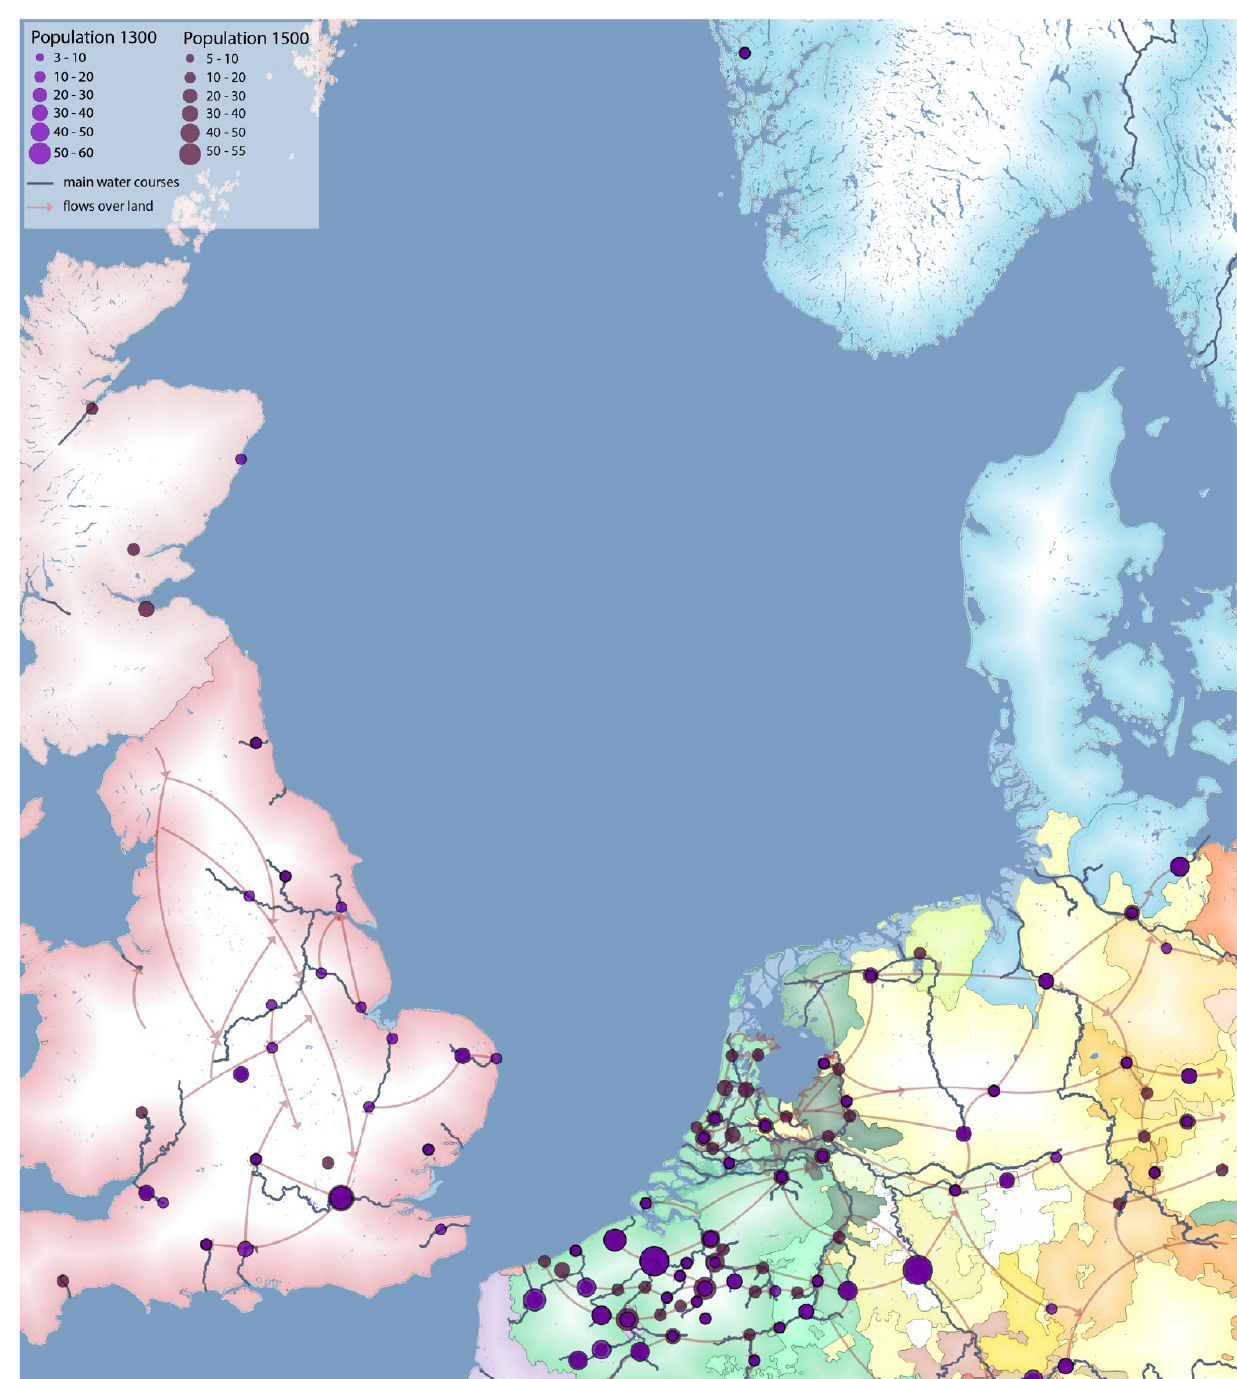
Figure 4. Cities around the North Sea area with the largest populations in 1300 and 1500, combined with political bound‐ aries and flows of goods and people over land and water in 1500. Map by Yvonne van Mil. Source: van Mil and Rutte (2020a,